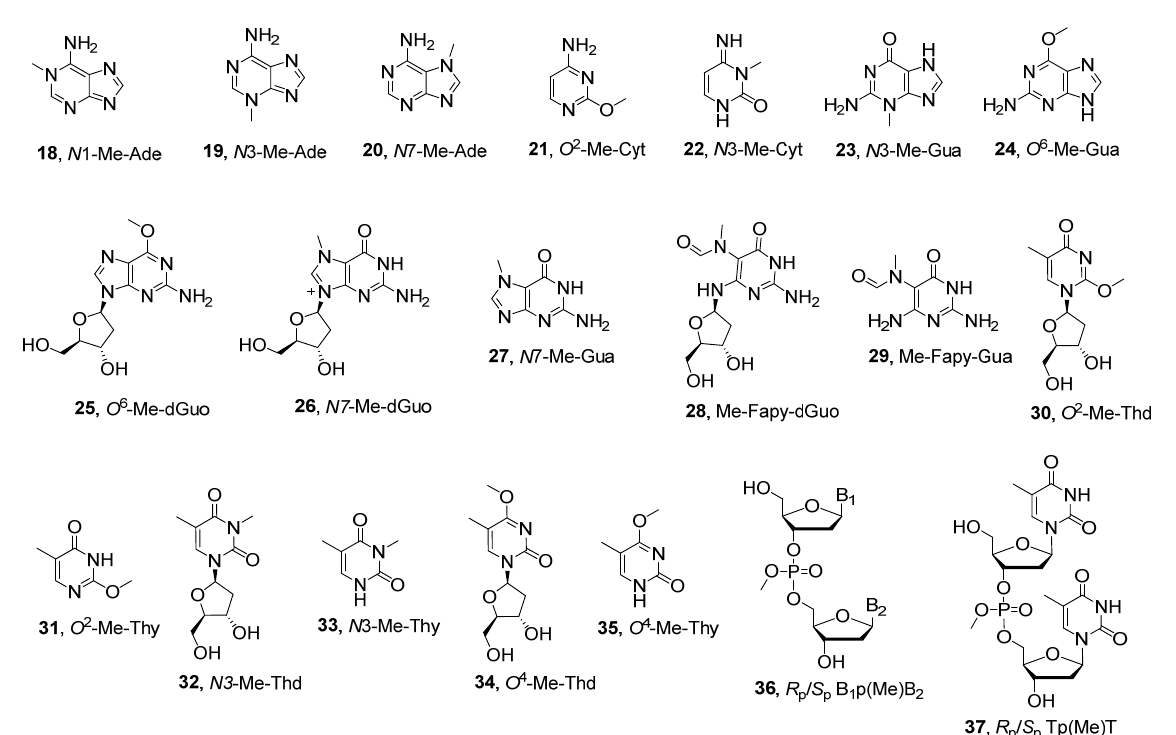
Figure 3. Structures of methyl DNA base and phosphate adducts.